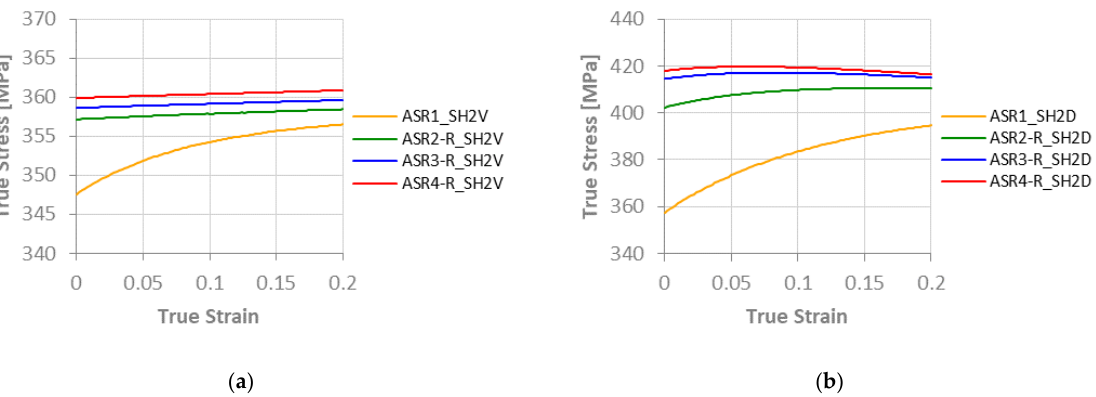
Figure 7. Stress–strain curves of a four-pass asymmetric-reverse rolling sequence, with 20% reduction per pass, considering a shear strain of 0.21 (SH2), and without considering texture evolution using: ( a ) a Voce-type hardening law (V) and ( b ) the DDR model (D).